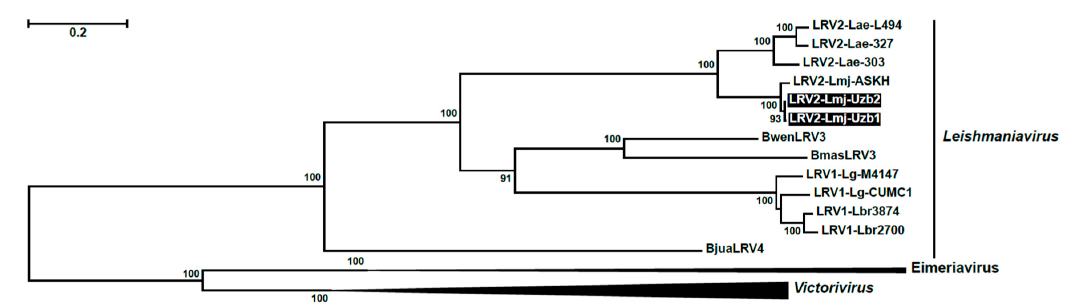
Figure 3. Maximum likelihood tree of LRVs built on amino acid sequence alignment using LG + F + I + G4 model. Newly identified isolates are highlighted in black. Standard bootstrap support (1000 replicas) values above 85 are shown. Victorivirus and Eimeriavirus ( Totiviridae ) were used as an outgroup. Scale bar represents the number of substitutions per site.